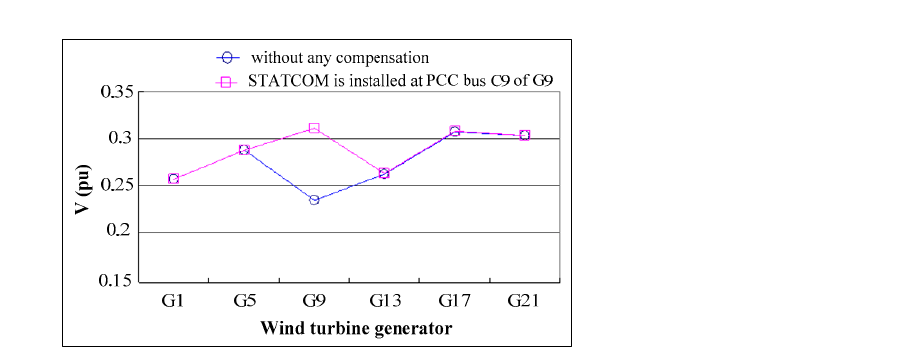
Figure 13. Comparison results of the output voltage supplied by the first set generator in each group.